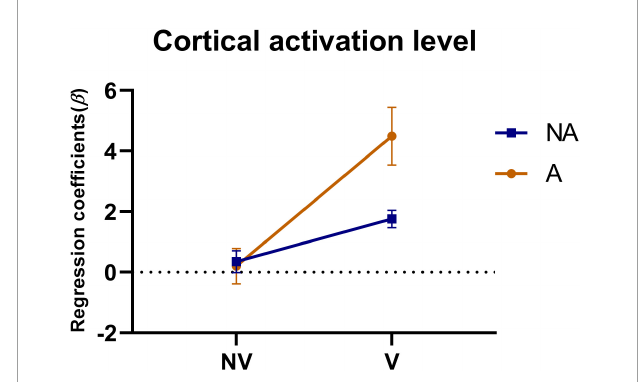
FIGURE8 Statistical analysis of the regression coefficients ( β ) under the presence or absence of visual feedback or auditory feedback. A simple representation was given in the figure. NV, no visual feedback; V, visual feedback; NA, no auditory feedback; A, auditory